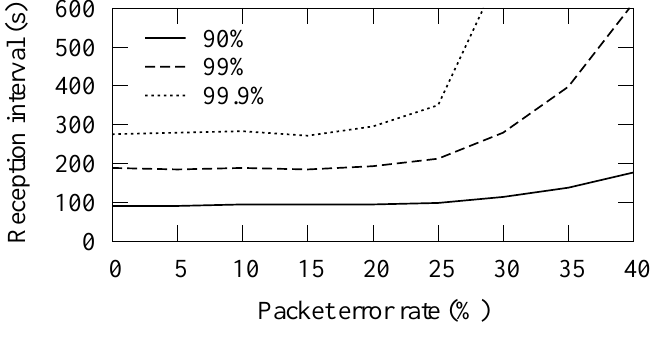
Figure 15. Availability intervals with 90%-99.9% availability in TUTWSN (12 sources, 5.5 B/s offered